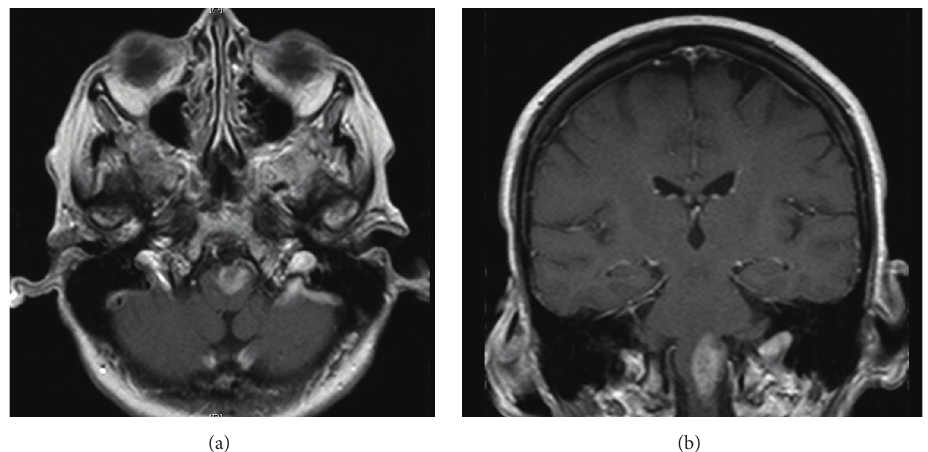
Figure 2: Brain MRI 2 weeks after the initial MRI. (a) Axial T1-weighted image with gadolinium, showing the enhancing left medullary lesion increased in size. (b) Coronal T1-weighted image with gadolinium showing the same medullary lesion increased in